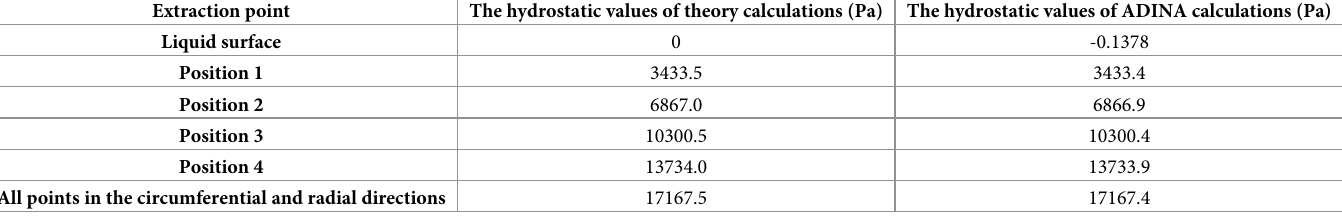
Table 8. Comparison of calculation results for hydrostatic pressure. Extraction